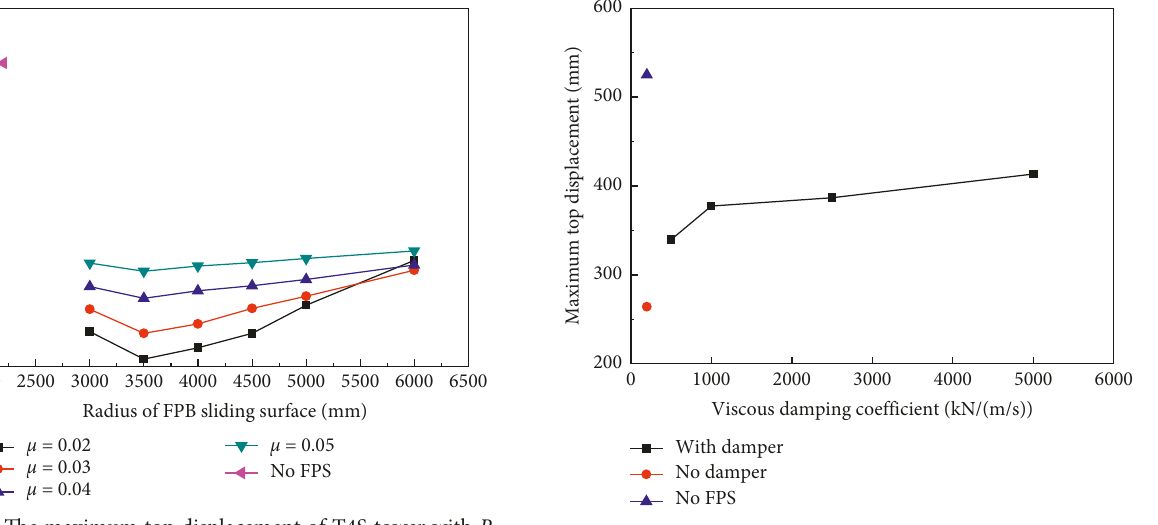
Figure 28: The maximum top displacement of T2 tower with FPBs d ( R d 4500, μ 0 . 02) and varying viscous damping coefficients in (cid:31) (cid:31) the Y direction under L0689S wave.